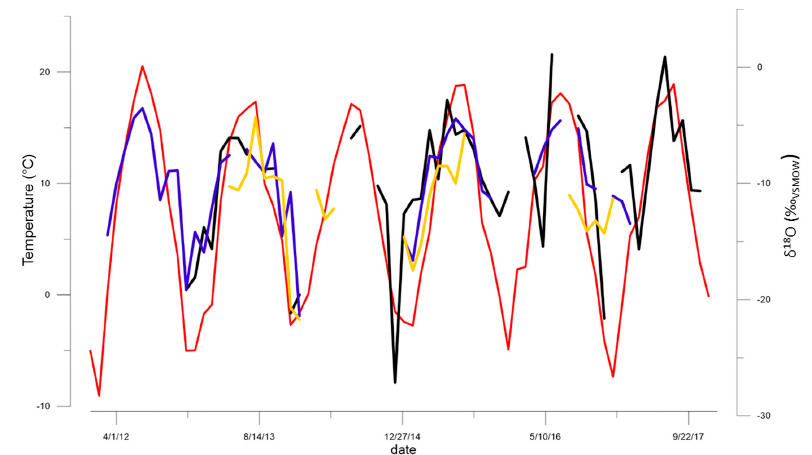
Figure 5. Monthly variation of mean temperature (red) from the gridded E-OBS (daily gridded observational dataset) of the nearest point of the stations and δ 18 O in precipitation at BN (blue), SV (black) and RA (yellow).